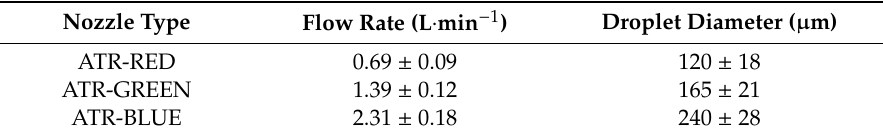
Table 5. Flow rates and droplet diameters of the three nozzle types.